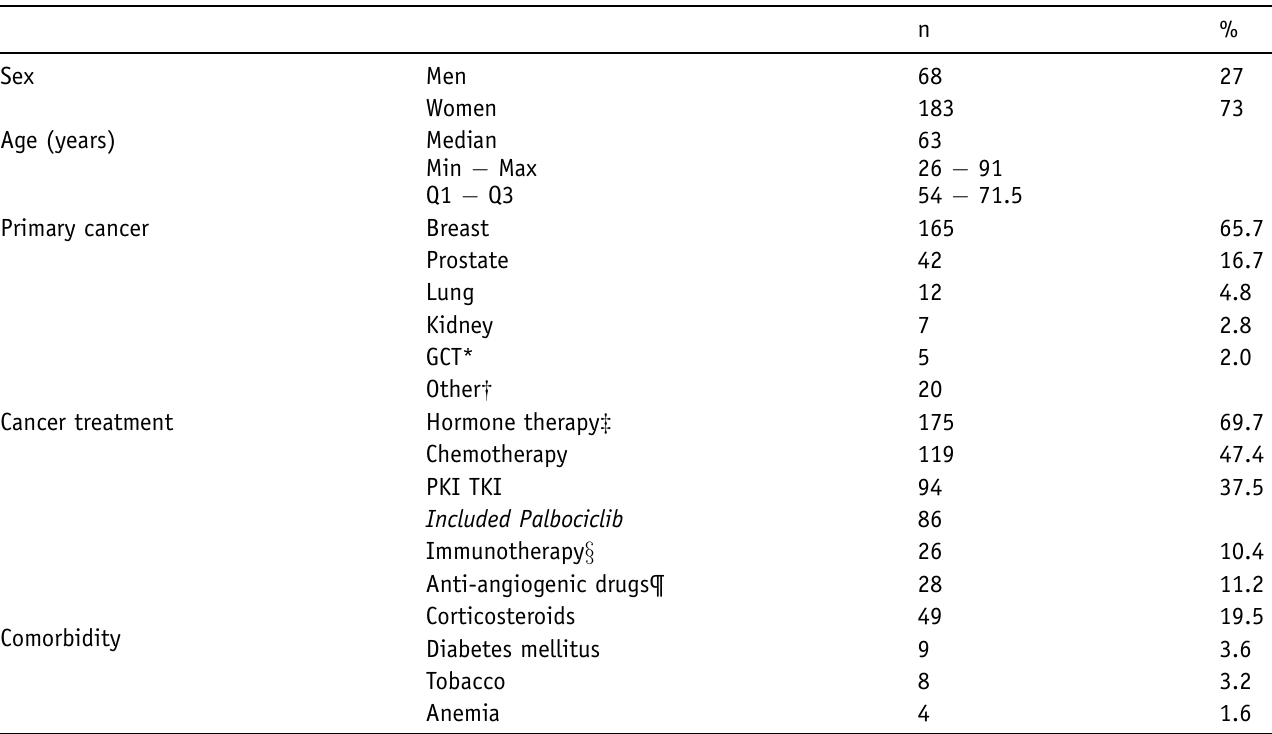
Table II. Patients ’ baseline